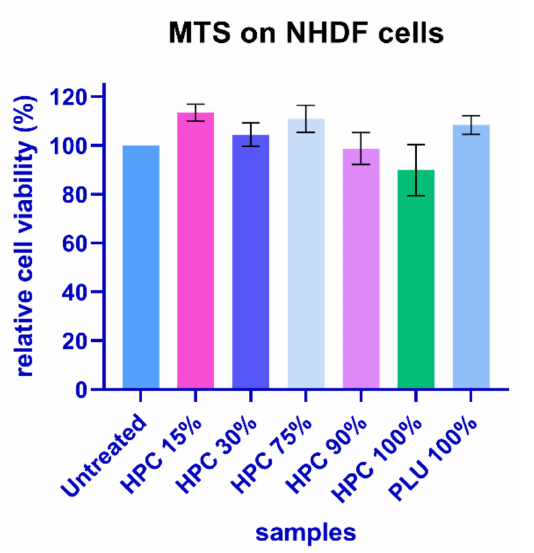
Figure 10. Relative cell viability according to the MTS assay. NHDF cells were cultivated in the presence of test materials for 48 h. The values represent means ± S.E.M., n = 3. p < 0.05 (HPC 100%); p < 0.01 (HPC 90%, HPC 75%); p < 0.001(HPC 30%); p < 0.0001 (Pluronic 100%, HPC